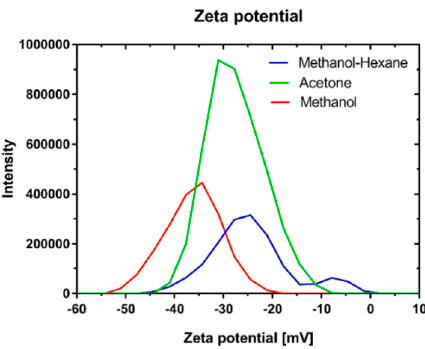
Figure 4. Zeta potential graphs of A-OMAgNs with a maximum value of ζ = − 28.6 mV; M-OMAgNs with a maximum value of ζ = − 37.3 mV; MH-OMAgNs with a maximum value of ζ = − 30.7 mV.